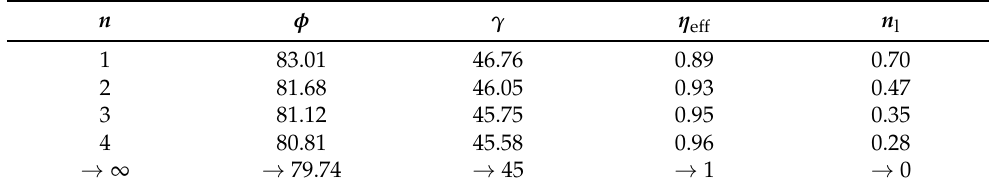
Table 2. Numerical solutions for the maximum cross-sectional area for various numbers of cross- thread